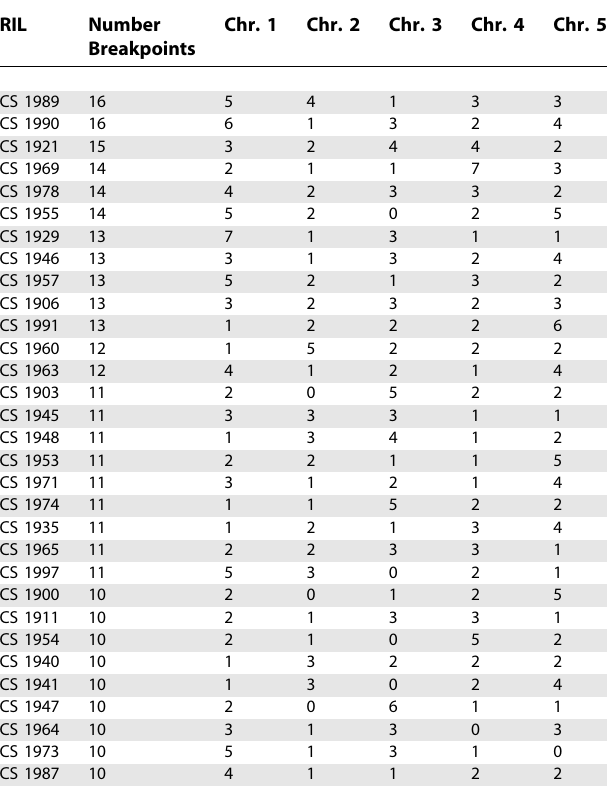
Table 2. RILs with Highest Number of Recombination Break- points RIL Number